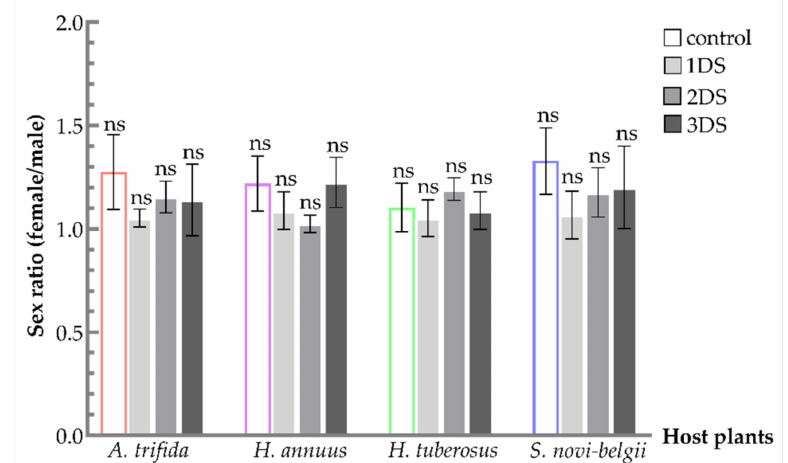
Figure 4. Sex ratio of C. marmorata suffering from food deprivation on four host plants. Control: the group offered host leaflets continuously without food deprivation; 1DS: the group subjected to 1 day’s starvation; 2DS: the group subjected to 2 days’ starvation; and 3DS: the group subjected to 3 days’ starvation. Values are the mean ± SD. Letters “ns” in one species of host plants indicate differences that are not significant (one-way analysis of variance followed by Duncan’s test, p > 0.05).